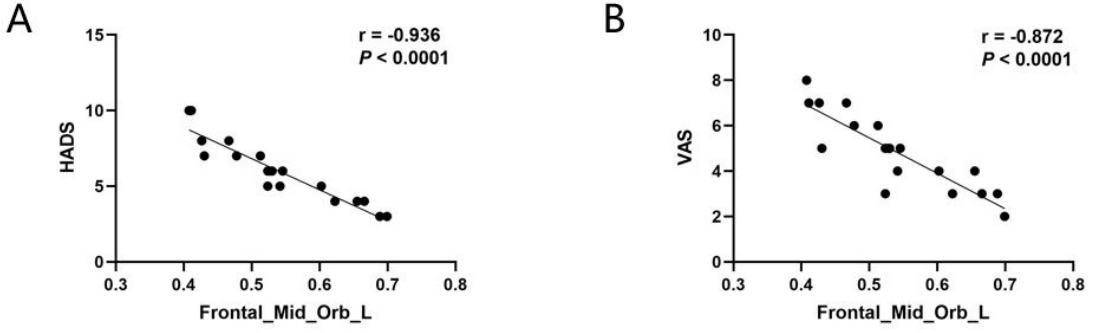
Fig.3. CorrelationanalysisbetweenthescoreofHADSandtheGMVvaluesoftheFrontalMidOrbL. (A)GMVvaluesshowedanegativecorrelation with the scores of HADS (r = –0.936, p < 0.0001). (B) GMV values showed a negative correlation with the scores of VAS (r = –0.872, p < –0.0001). HADS, hospital anxiety and depression scale; VAS, Visual Analogue Score; GMV, gray matter volume. Frontal Mid Orb L, middle frontal gyrus, orbital part.